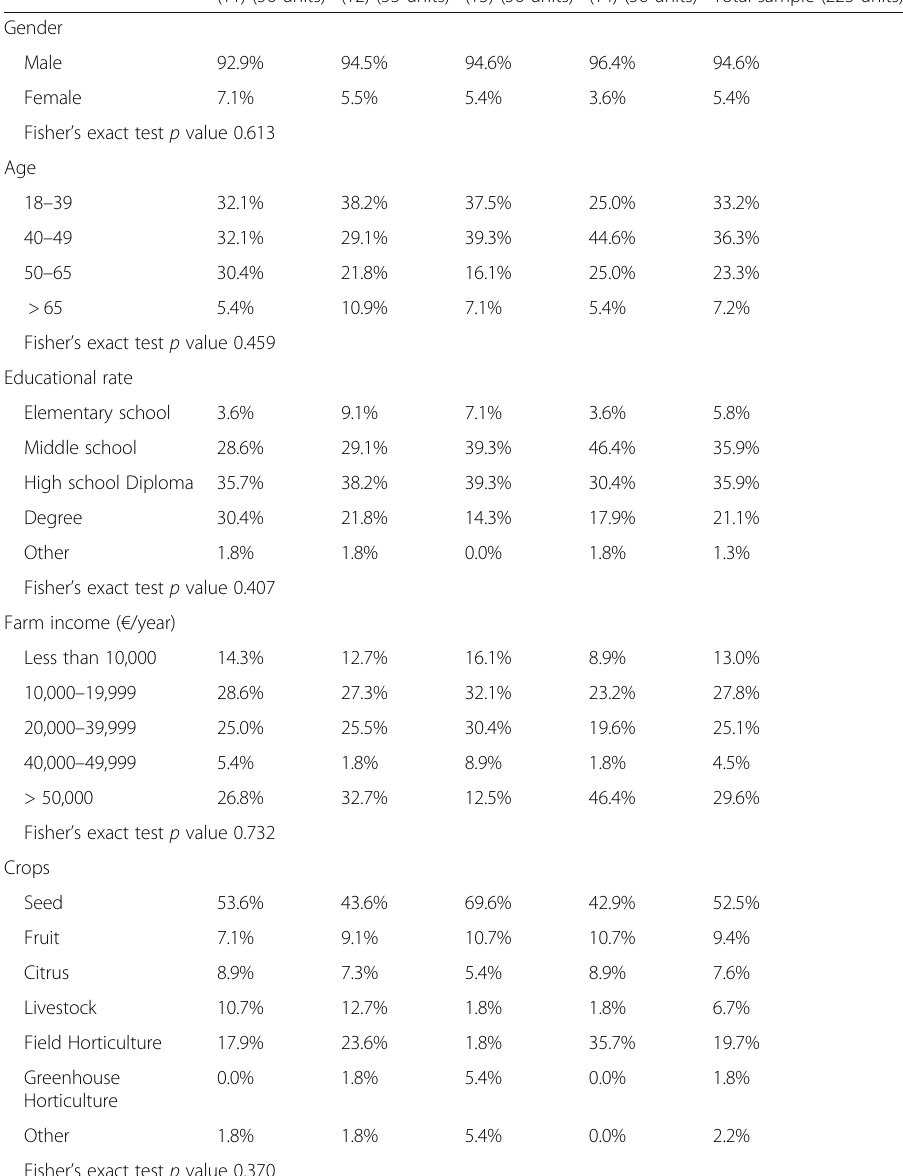
Table 3 Socio-demographic characteristics